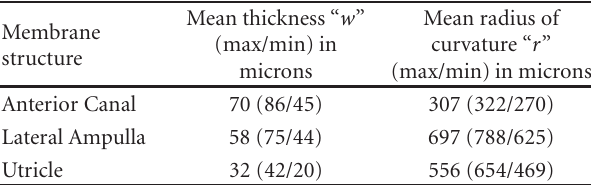
Table 1: Live measurements of the toadfish labyrinth ∗ . Membrane